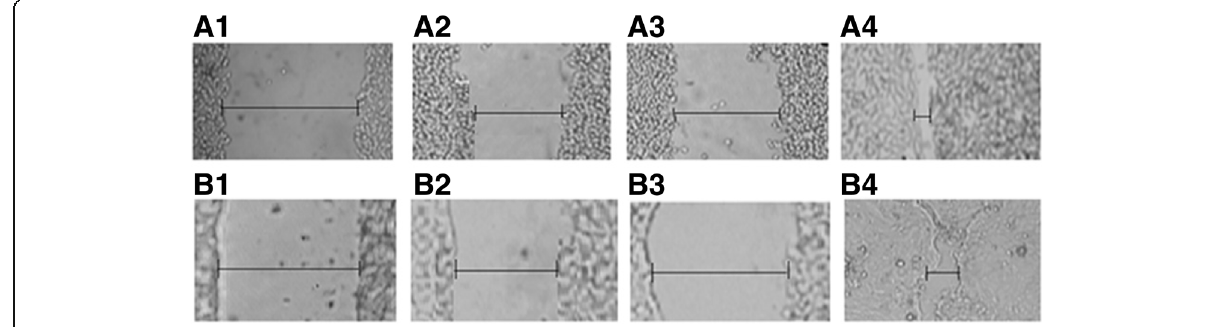
Fig. 2 Images of the scratch wound assay of dichloromethane extract of F. racemosa on (a) BHK cells, A1- control at t =0 h, A2- control at t =24 h, A3- DCM extract at t =0 h, A4- DCM extract at t =24 h; (b) MDCK cells, B1- control at t =0 h, B2- control at t =24 h, B3- DCM extract at t =0 h, B4- DCM extract at t =24 h